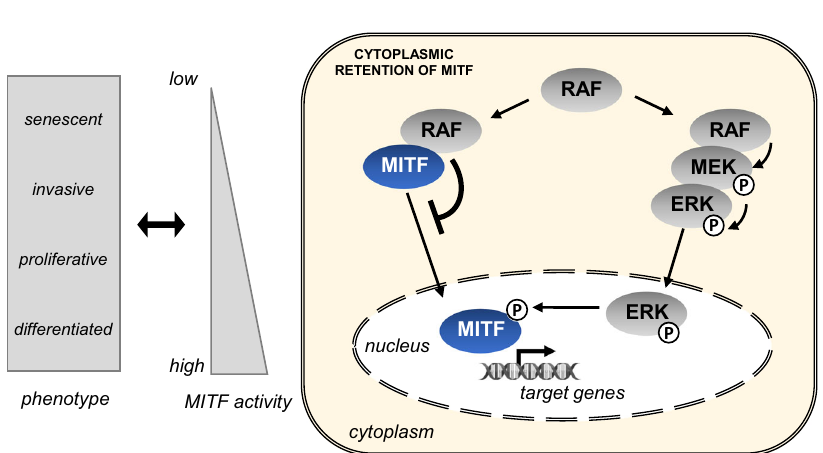
Fig. 7 Hypothetical model. Scheme illustrating the regulation of MITF activity by direct binding with RAF kinases. Model illustrating the regulation of MITF activity by direct binding with RAF